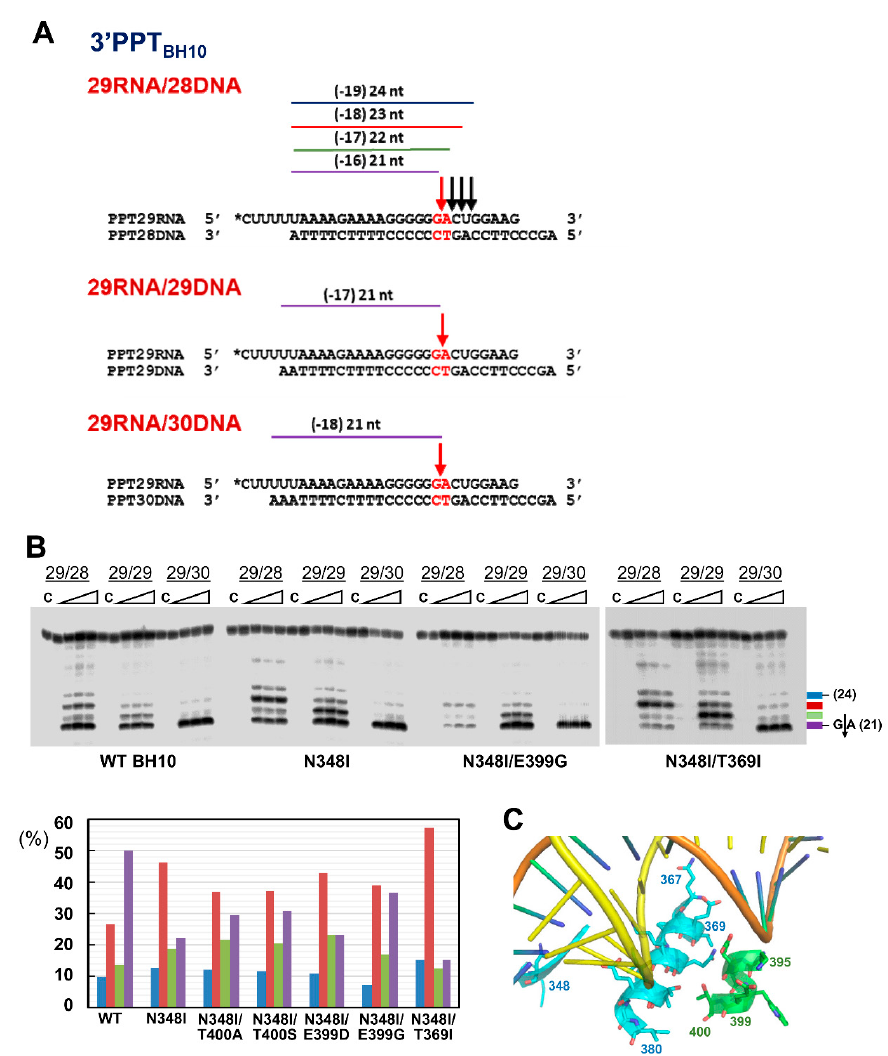
Figure 4. Effect of HIV-1 BH10 RT connection subdomain mutations on the RNase H cleavage window. ( A ) Template-primers used in the assay and major cleavage sites observed. Arrows and texts in red indicate the location of the PPT/U3 cleavage site in the RNA/DNA complexes used. ( B ) Reactions were carried out in the presence of RT and template-primer at concentrations of 125 nM and 25 nM, respectively. RT and template-primer were pre-incubated for 5 min at 37 °C, and aliquots were withdrawn at 0, 20, 40 and 180 s after the addition of magnesium and heparin. Lane C shows control experiments including heparin in the pre-incubation buffer. Numbers above indicate the template-primer used in each experiment: 29/28, 29/29 and 29/30 for 29RNA/28DNA, 29RNA/29DNA and 29RNA/30DNA hybrids, respectively. Histograms below indicate the relative proportions of hydrolysis products obtained with mutant RTs and the 29RNA/28DNA complex and were obtained from at least three independent experiments. Less than 5% inter-assay variabilities were observed in these assays. Blue, red, green and purple bars represent the relative amounts of RNase H cleavage products of 24, 23, 22 and 21 nucleotides, respectively. ( C ) WT HIV-1 RT structure of the connection subdomain showing the location of relevant residues in p66 (Asn348, Thr369) and p51 (Glu399, Thr400). The template strand is shown in yellow, while the primer strand is shown in orange. The image was prepared using Pymol and the Protein Data Bank structure 6UIS.